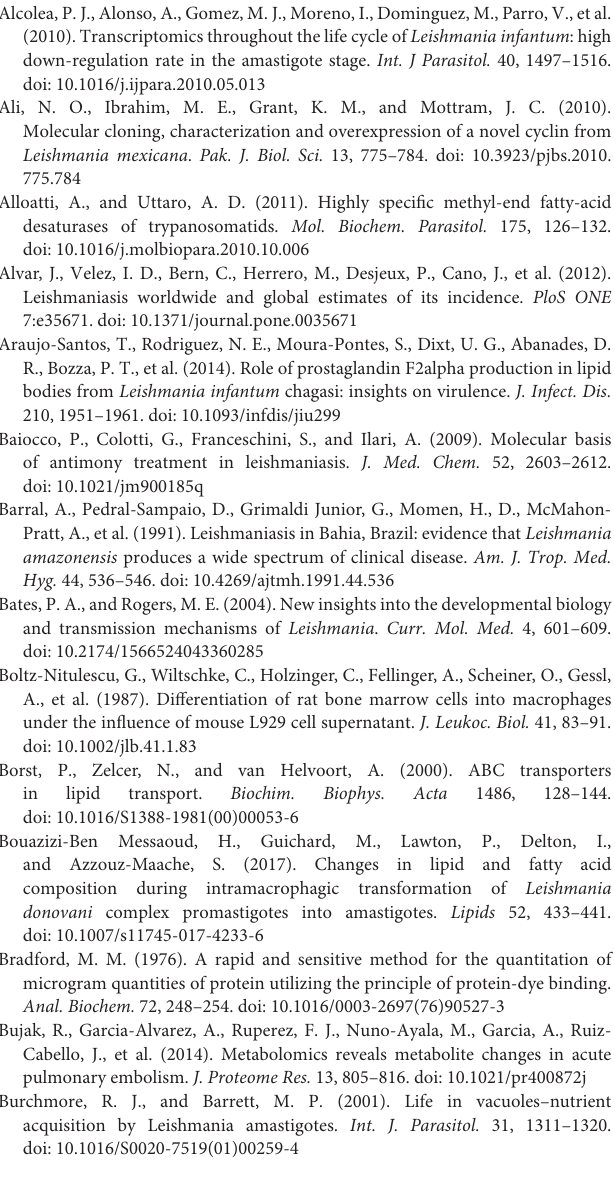
Supplemental Figure 4 | Scores plot for PLS-DA. Models built with the filtered data set for each analytical technique obtained from R0, R10, R40, and R60 extract samples, provided by SINCA p + statistical software demonstrating evident separation among the groups in supervised analysis, except for the LC-MS positive mode. The predictive coefficients values demonstrated a strong statistical trend regardless the analytical techniques, for CE-MS [R 2 = 0.983, Q 2 = 0.947], GC-MS [R 2 = 0.594, Q 2 = 0.342] and LC-MS [R 2 = 0.582, Q 2 = 0.262 in positive, and R 2 = 0.744, Q 2 = 0.201, in negative mode]. Supplemental Figure 5 | Determination of gates for aPS exposure. (A) Unlabeled parasites. (B) Parasites marked only with PE annexinV (aPS exposure). (C) Parasites marked only with 7-AAD (unviable parasites).